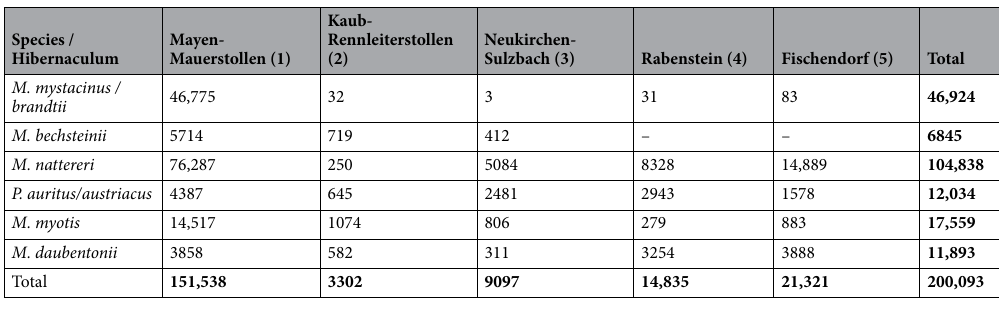
Table 2. Number of photographs per included species per site.